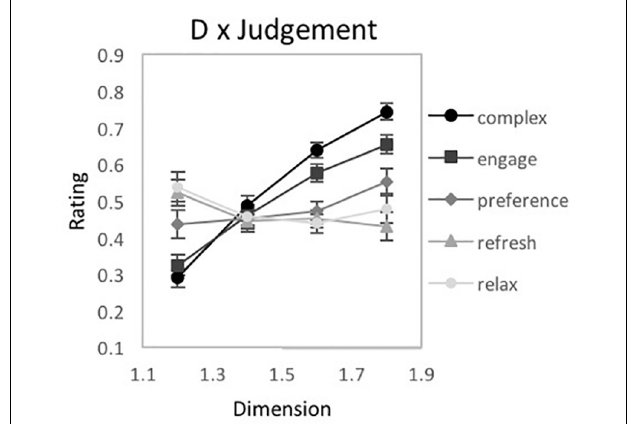
FIGURE 10 | Experiment 2 results for ‘tree-seed’ fractal patterns using a unipolar rating scale. Results show a significant interaction between fractal dimension ( D ) and judgment type (complex, engaging, preferred, refreshing, and relaxing). Participant rating (on a scale from 0 to 1) is plotted as a function of D -value for the different judgment